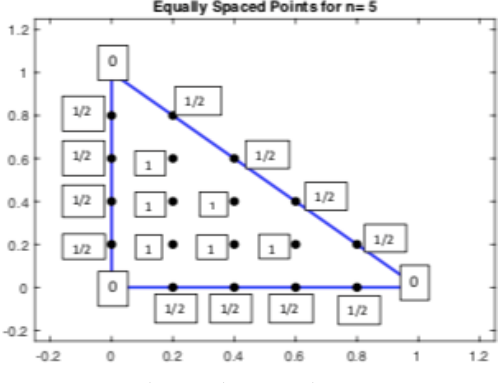
Figure 9. Weights on the